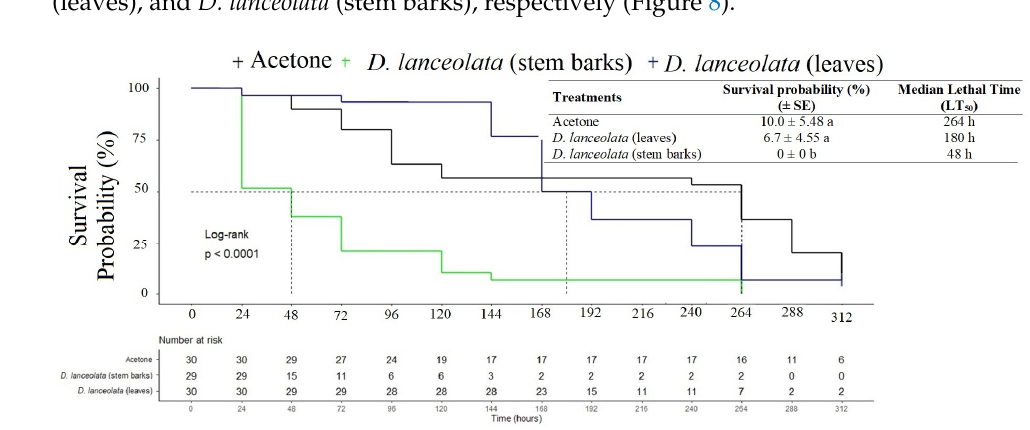
Figure 8. Survival analysis of adult females of Trichogramma pretiosum that received eggs from Ephestia kuehniella treated with essential oils from the leaves and stem barks of Duguetia lanceolata. The same letters do not differ statistically by Pairwise multiple comparison test.